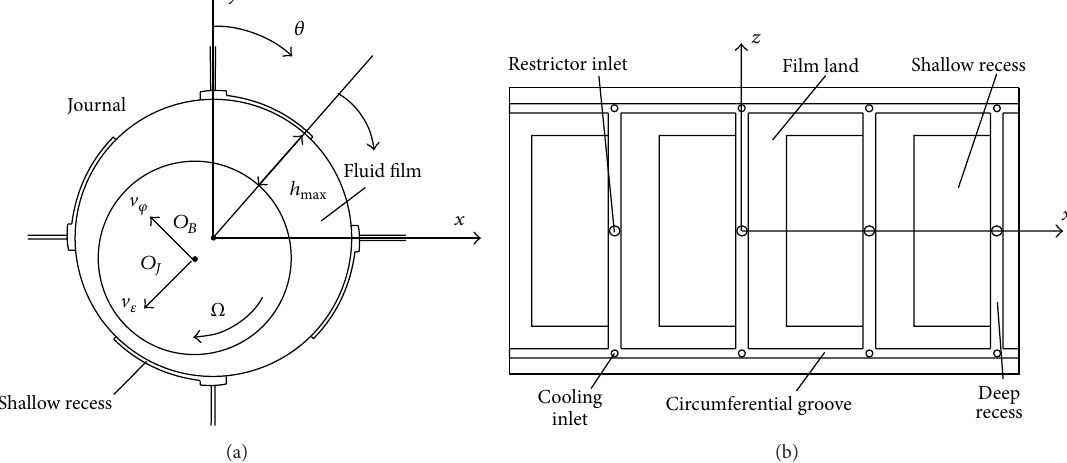
Figure 2: Geometry and coordinate system of the hybrid bearing (a) cross section view and (b) developed view of the bearing surface.